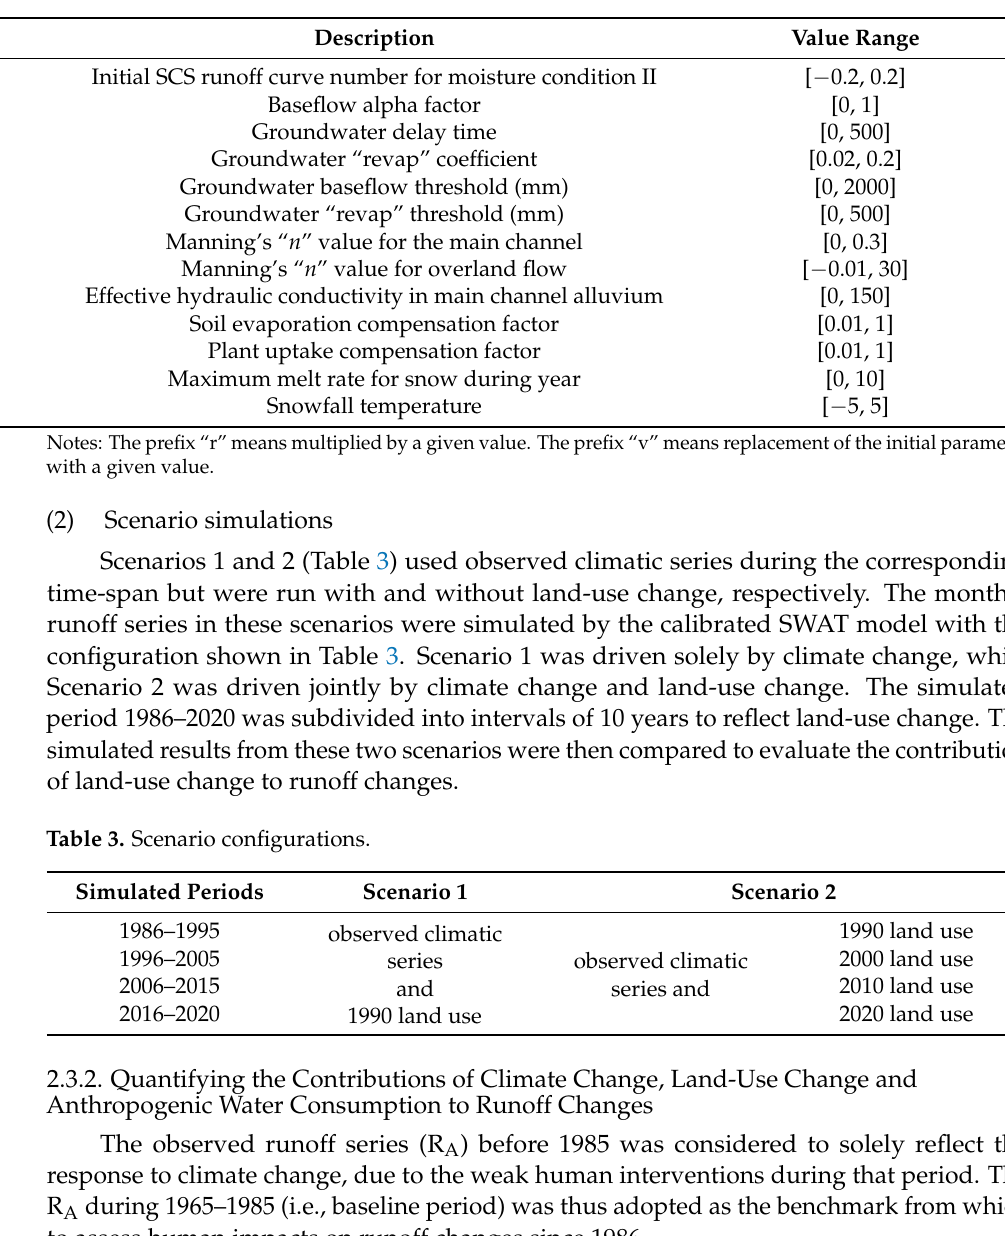
Table 2. Parameters used for calibration in the SWAT model.